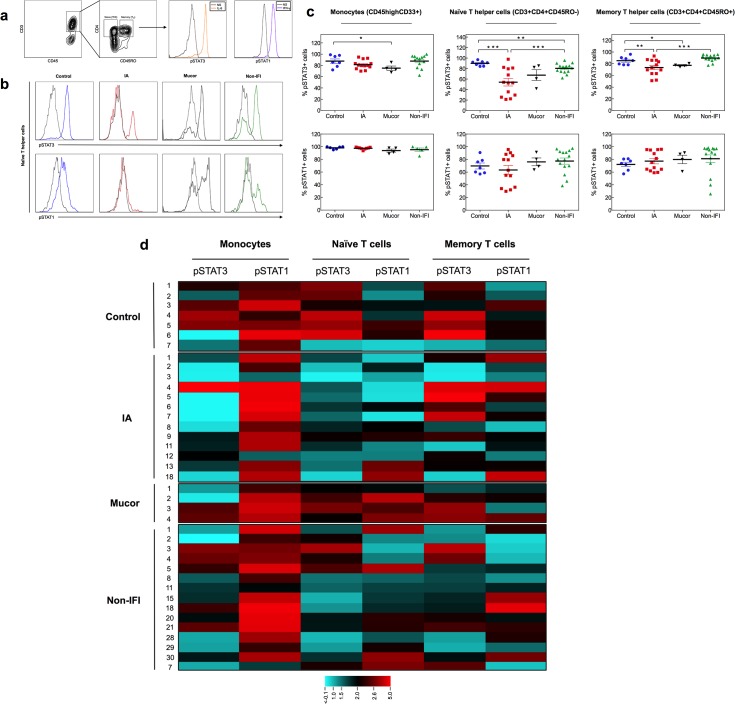
STAT1 and STAT3 phosphorylation in hematological patients with IMI.(a-d) IFN-γ-induced STAT1 phosphorylation and IL-6-induced STAT3 phosphorylation were measured in peripheral blood mononuclear cells using phospho-flow. (a) On the left, representative dot plots for gating of naïve and memory CD4+ T cells are shown; gating of T cells (CD3+) or monocytes (CD33+, not shown) was done on CD45high cells in order to avoid interference of the analysis by potential blasts in leukemic patients with residual disease. On the right, representative histograms of the levels of phosphorylated STAT (pSTAT) proteins in non-stimulated (NS) and cytokine-stimulated cells are shown; baseline pSTAT levels are shown in grey, IFN-γ-induced pSTAT1 is shown in purple and IL-6-induced pSTAT3 is shown in orange. (b) Representative histograms of IL-6 induced pSTAT3 (top row) and IFN-γ-induced pSTAT1 (bottom row) in different patient groups. Y axis corresponds to number of events (i.e. number of naïve CD4+ T cells) and X axis corresponds to fluorescence intensity (i.e. pSTAT-Alexa Fluor 488). (c) Percentage of monocytes (CD45highCD33+ cells), naïve T helper (Th) cells (CD45highCD3+CD4+CD45RO- cells) and memory Th cells (CD45highCD3+CD4+CD45RO+ cells) expressing pSTAT3 (top row) and pSTAT1 (bottom row) in response to IL-6 and IFN-γ, respectively, in healthy controls (blue circles; n = 7), hematological patients with IA (red squares; n = 13) or mucormycosis (black inverted triangles; n = 4) and non-IFI hematological controls (green triangles; n = 15). *p<0.05, **p<0.01 and ***p<0.005 using the unpaired two-tailed Student’s t-test. Data are shown as mean ± s.e.m. (d) Heat map for log2 scale of mean fluorescence intensity (MFI) fold change. Fold change was calculated by dividing the MFI of the cytokine-stimulated sample by that of the unstimulated sample. Heat map color scale is showed in the bottom. Each row on the heat map corresponds to an individual patient or control as indicated by the study ID number on the left. Each column on the heat map corresponds to specific cell type/pSTAT as indicated on the top. Note reduced IL-6-induced pSTAT3 in monocytes (p = 0.01 for IA vs. healthy controls and p<0.05 for IA vs. non-IFI) and naïve CD4+ T cells (p = 0.006 for IA vs. healthy controls and p = 0.04 for IA vs. non-IFI) from patients with IA, using unpaired two-tailed Student’s t-test.